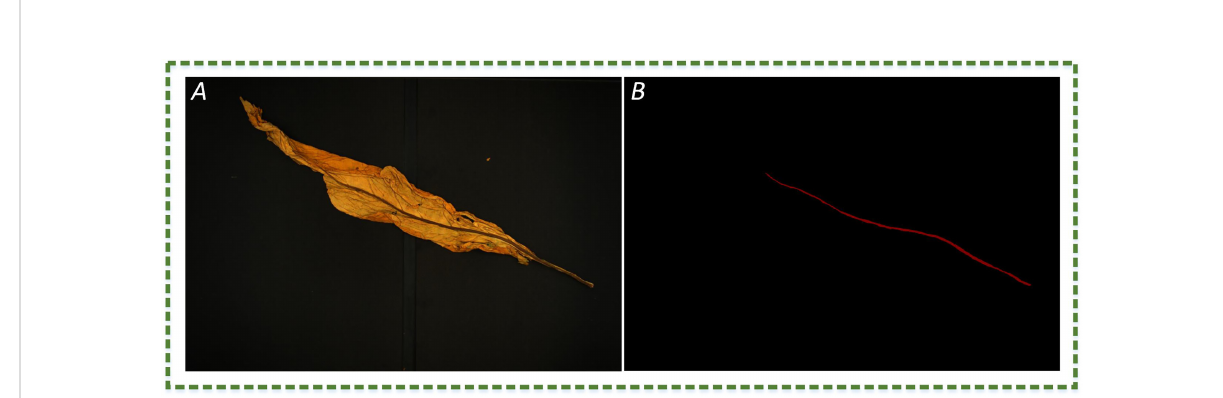
FIGURE 2 The image example. (A) The RGB image of plant leaves; (B) manual annotation of leaf vein region, where red and black represent the leaf vein and background, respectively.